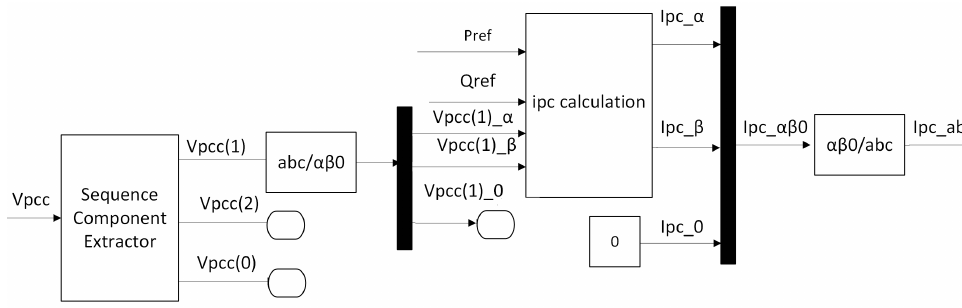
Figure 5. Power command current calculation.